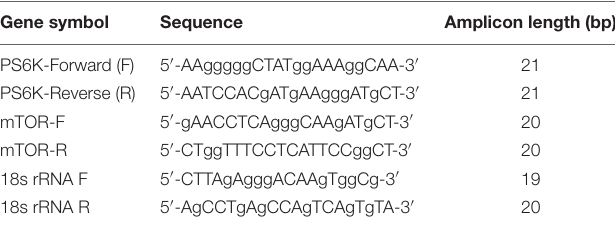
TABLE 2 | Primers used for real-time